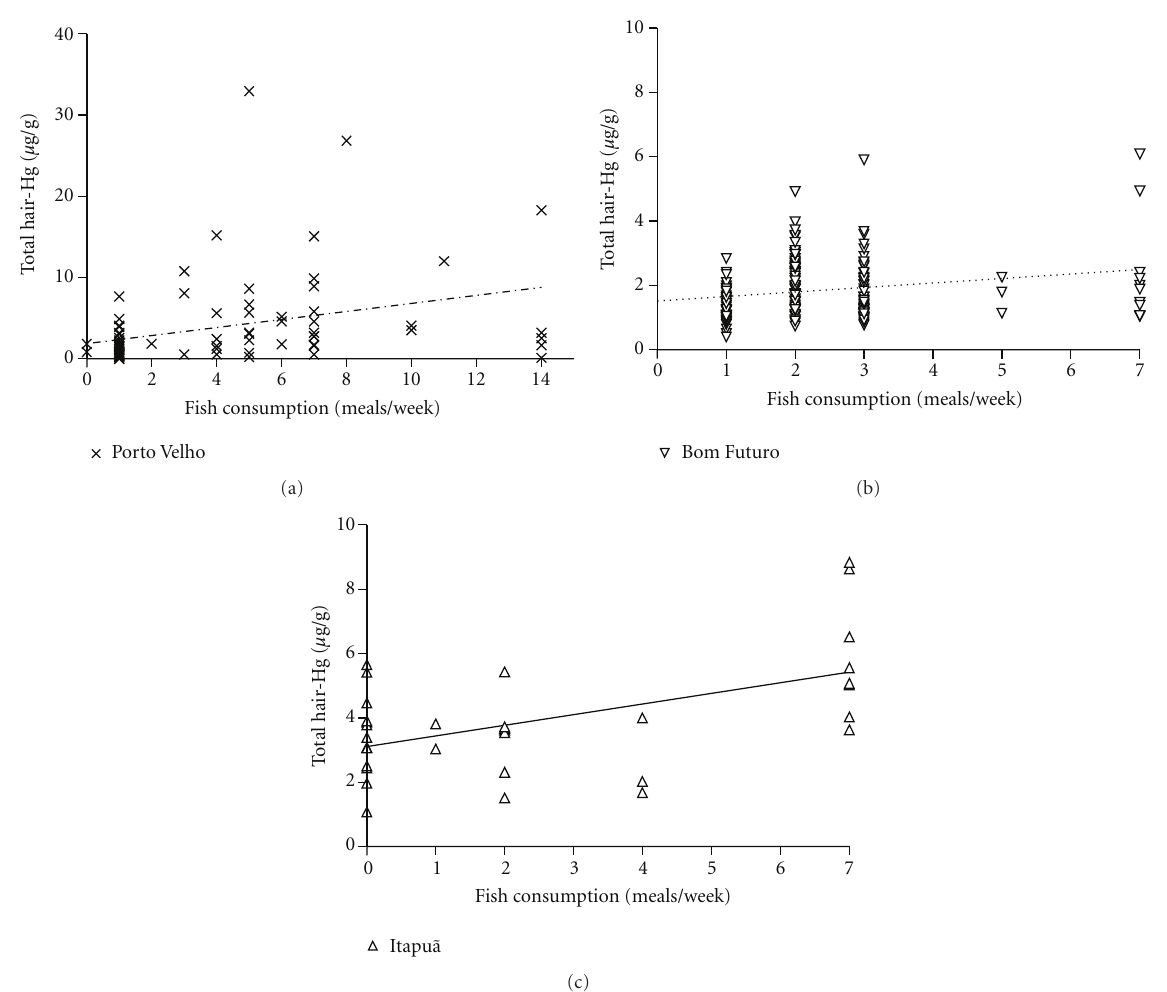
Figure 2: Scatter plots of infant’s total hair-Hg concentrations as a function of maternal fish consumption; the Porto Velho data “high” refers to eating > 2 fish meals a week.